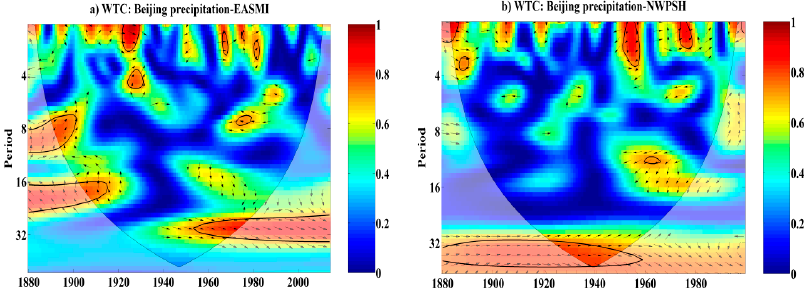
Figure 4. Wavelet Coherence Spectrum between EASMI ( a ); NWPSH ( b ) and precipitation of the Beijing area.